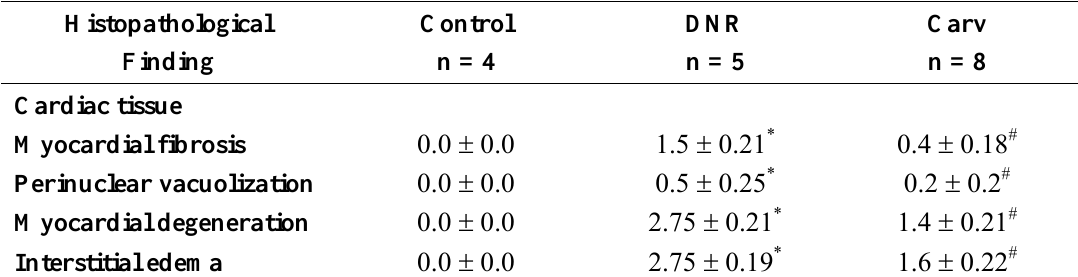
Table 2. Effect of carvedilol on histopatological changes in cardiac tissues after 6 weeks of treatment in DNR